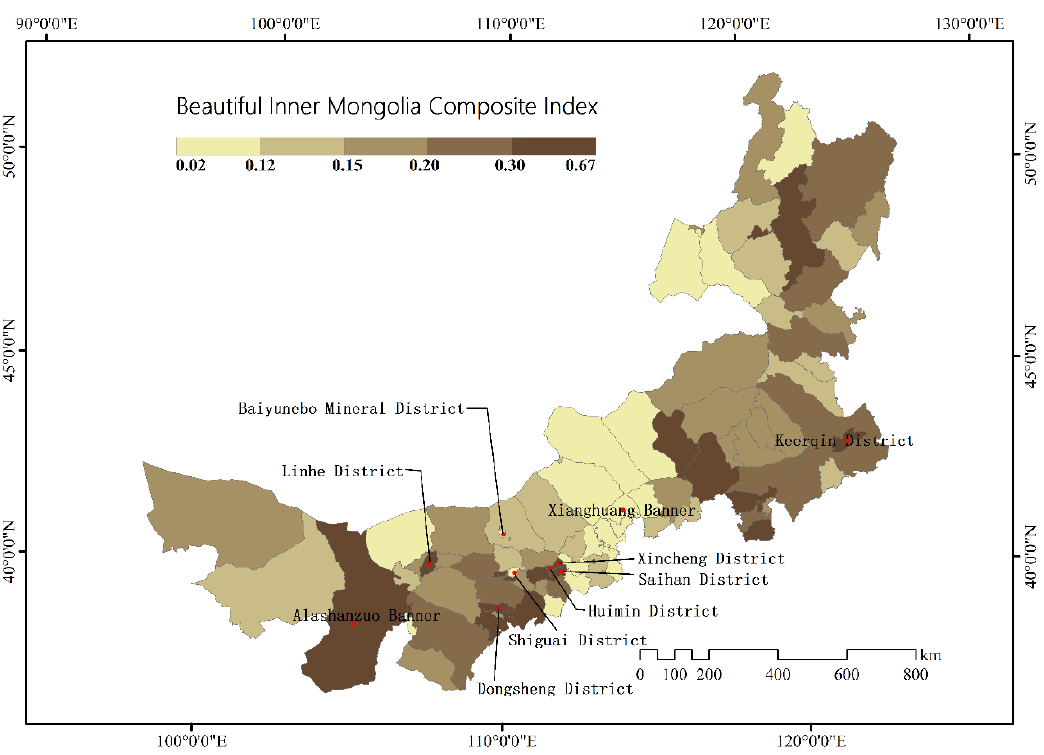
Figure 6. Spatial distribution of the composite Beautiful Inner Mongolia index in 2020. Using the radar chart, the evaluation results of the construction of a Beautiful Inner Mongolia in all 103 county-level administrative regions and five dimensions in the IMAR are displayed in Figure 7a. In terms of the scores of each dimension, the industrial development index of Inner Mongolia’s banners, counties, and districts was the highest (mean = 0.28), and the cultural heritage index was the lowest (mean = 0.18), revealing that the level of industrial development and the construction pressure in the field of the cultural heritage of all banners, counties, and districts in Inner Mongolia were relatively high. In terms of the degree of agglomeration of the scores of each dimension, the cultural heritage and social harmony indexes of each banner, county, and district were relatively scattered (the CVs were 94% and 89%, respectively), which showed that large regional differences existed in the different banners/counties, and districts in Inner Mongolia.